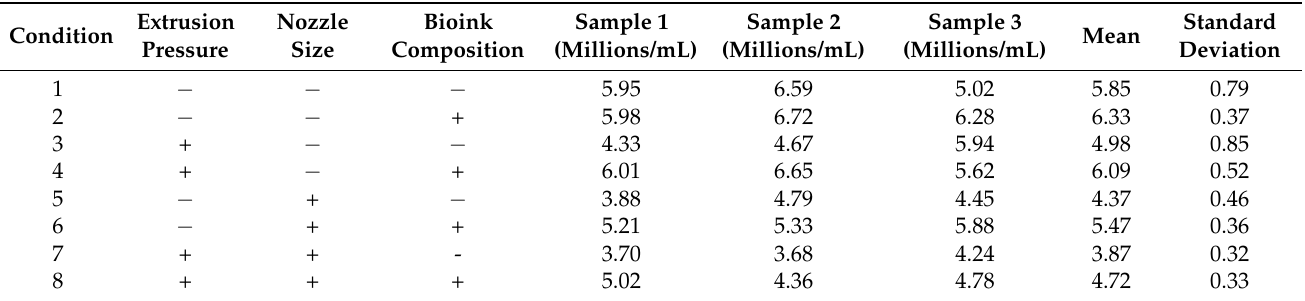
Table 6. Experimental data for cell viability measurements (living cell concentration).